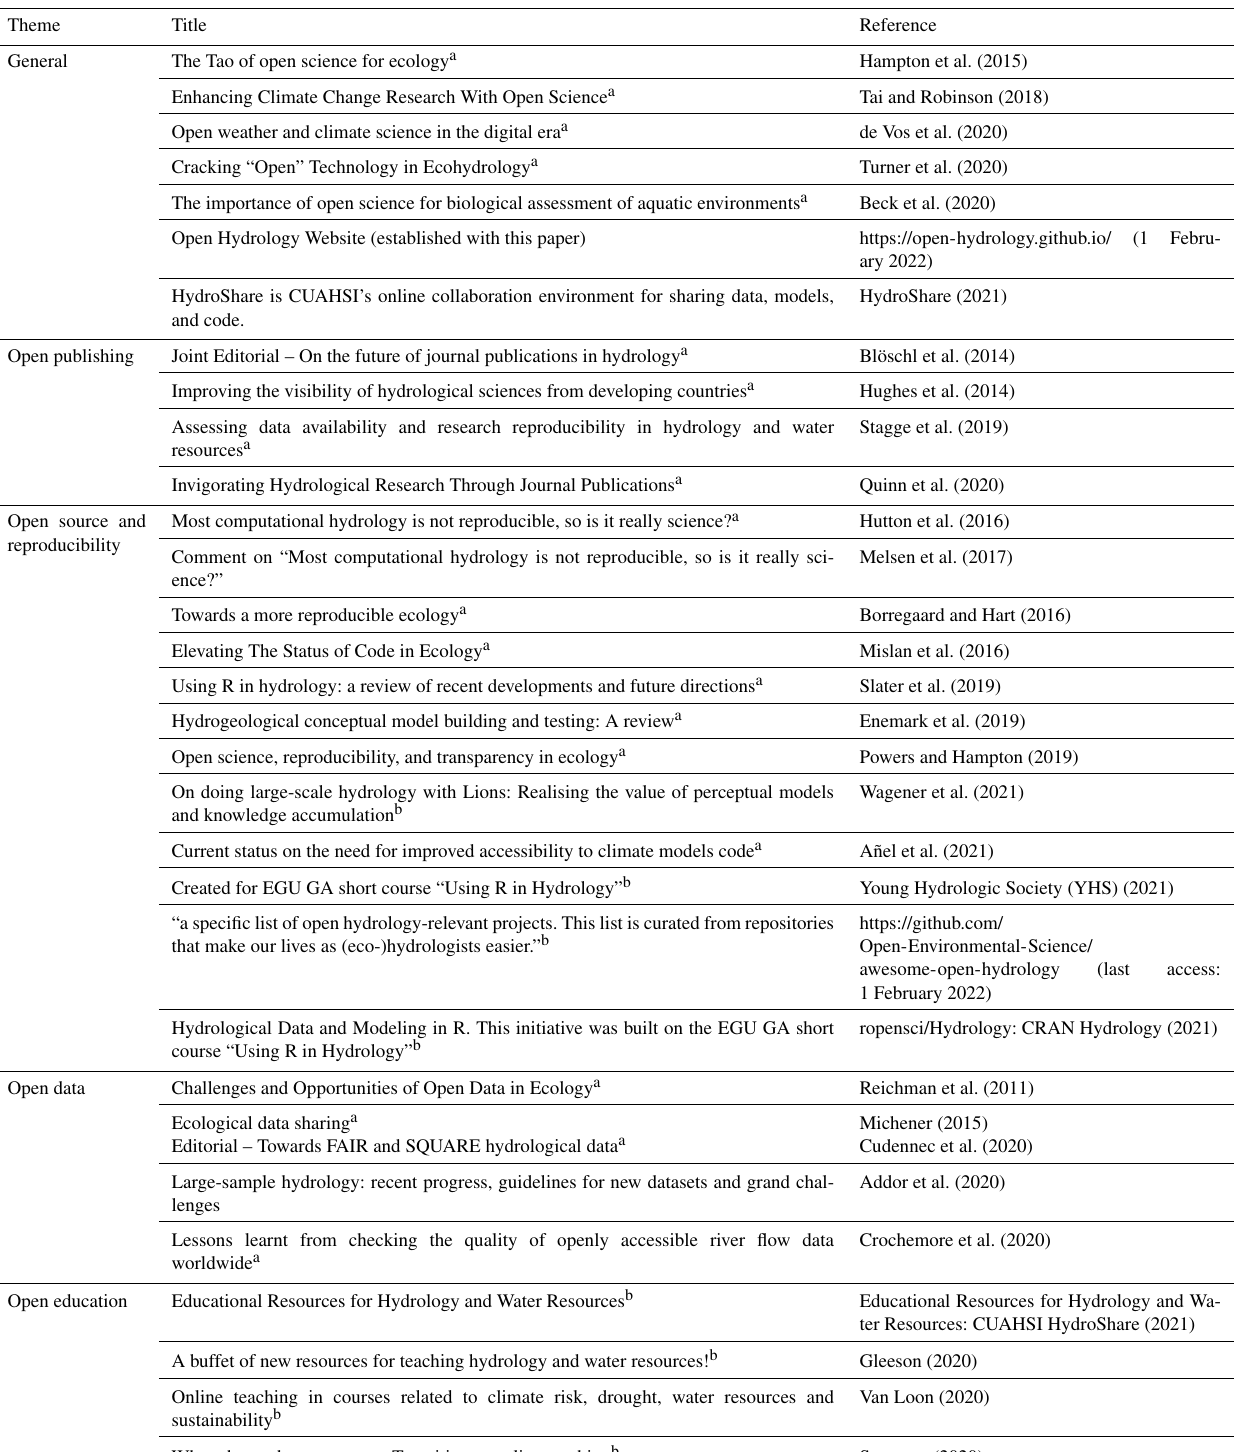
Table 1. A selection of efforts that discuss and support openness in hydrology and related sub-disciplines ( a peer-reviewed article, b community contribution). For an up-to-date resource list, see https://open-hydrology.github.io/resources/ (last access: 1 February